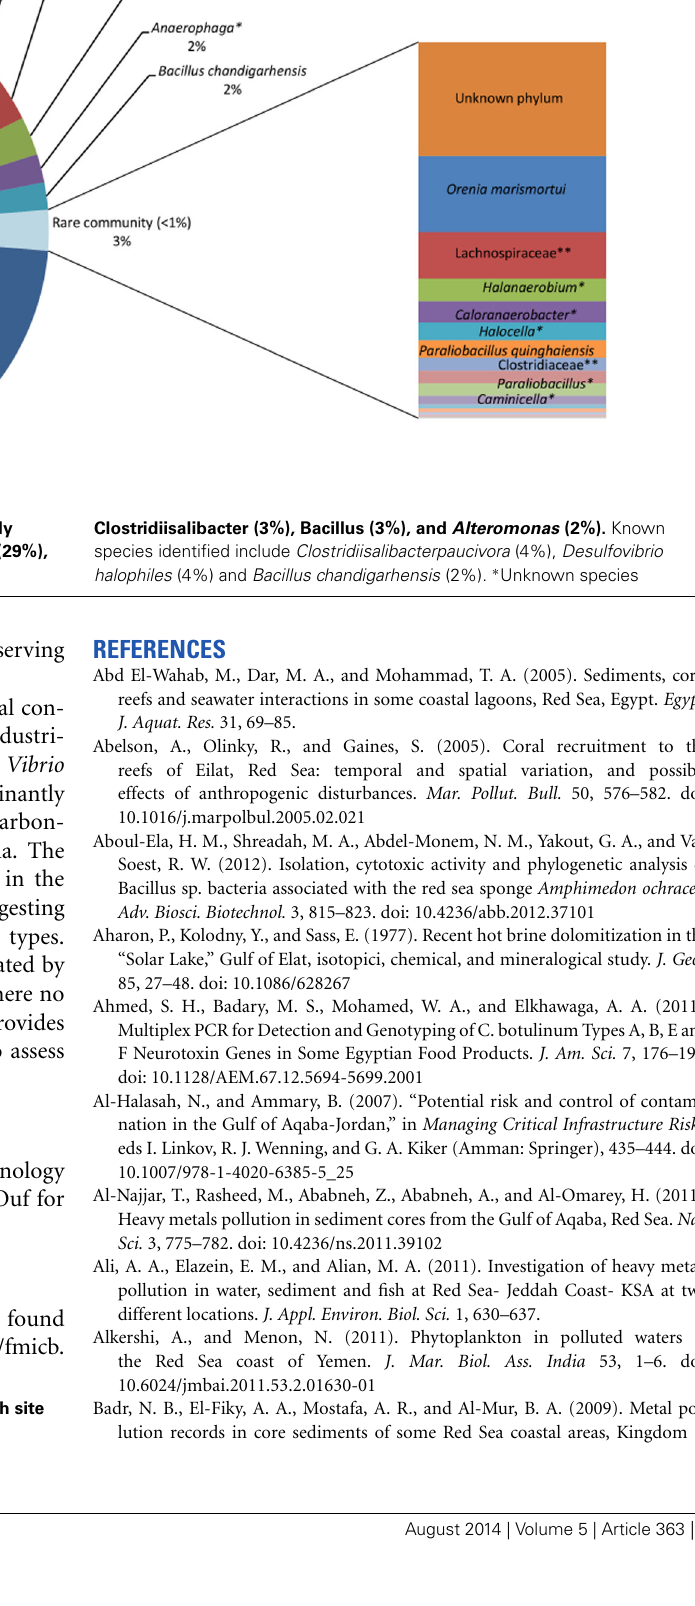
Table S1 | Bacterial communities comprisingmore than 0.1% in each site are